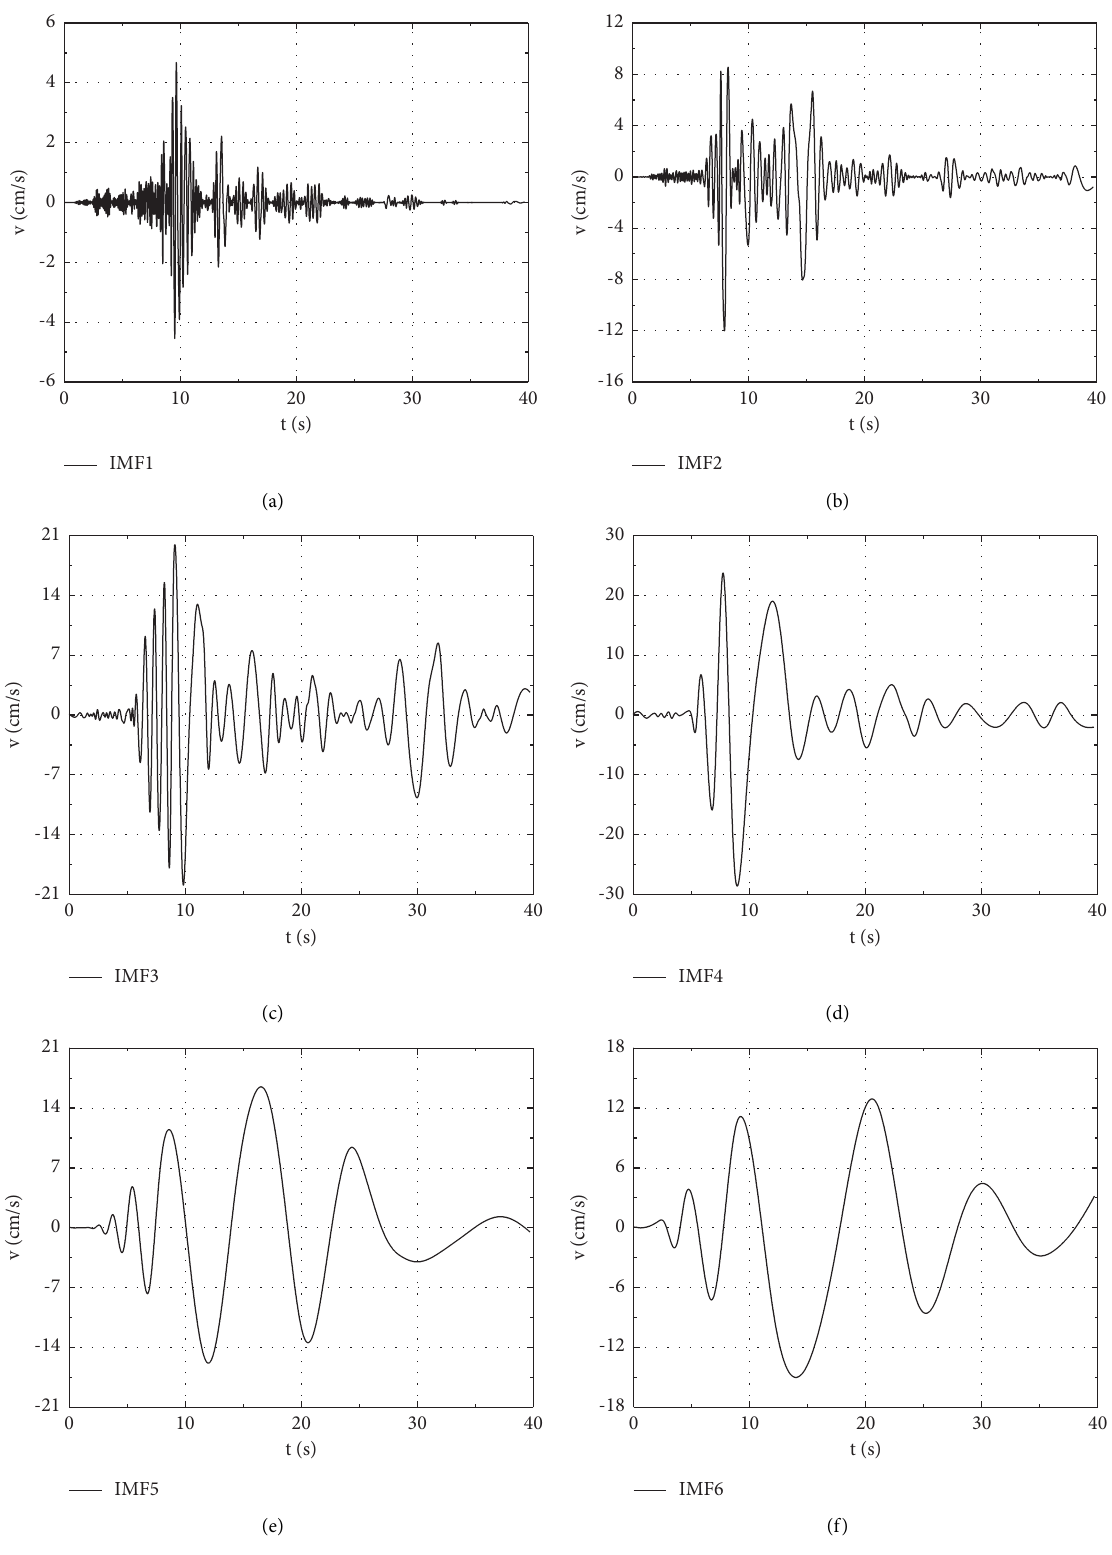
Figure 6: IMF components of the ground motion. (a) IMF1. (b) IMF2. (c) IMF3. (d) IMF4. (e) IMF5. (f)